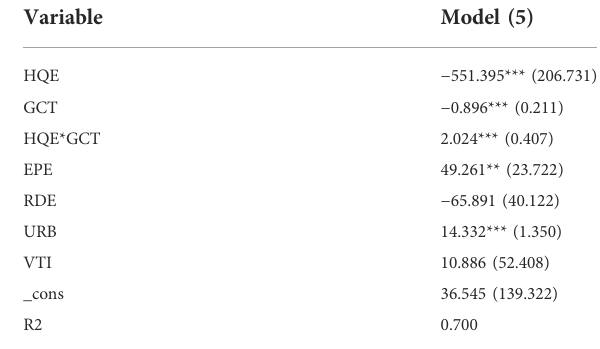
TABLE 9 Regulatory effect result.